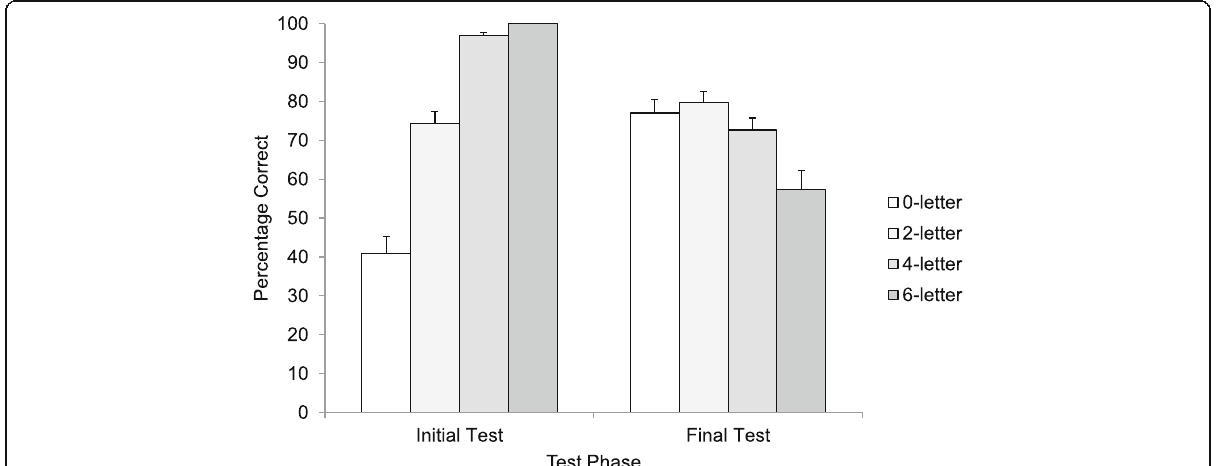
Fig. 4 Initial and final recall performance (reported as a percentage) as a function of trial type in Experiment 4. Error bars report standard error of the